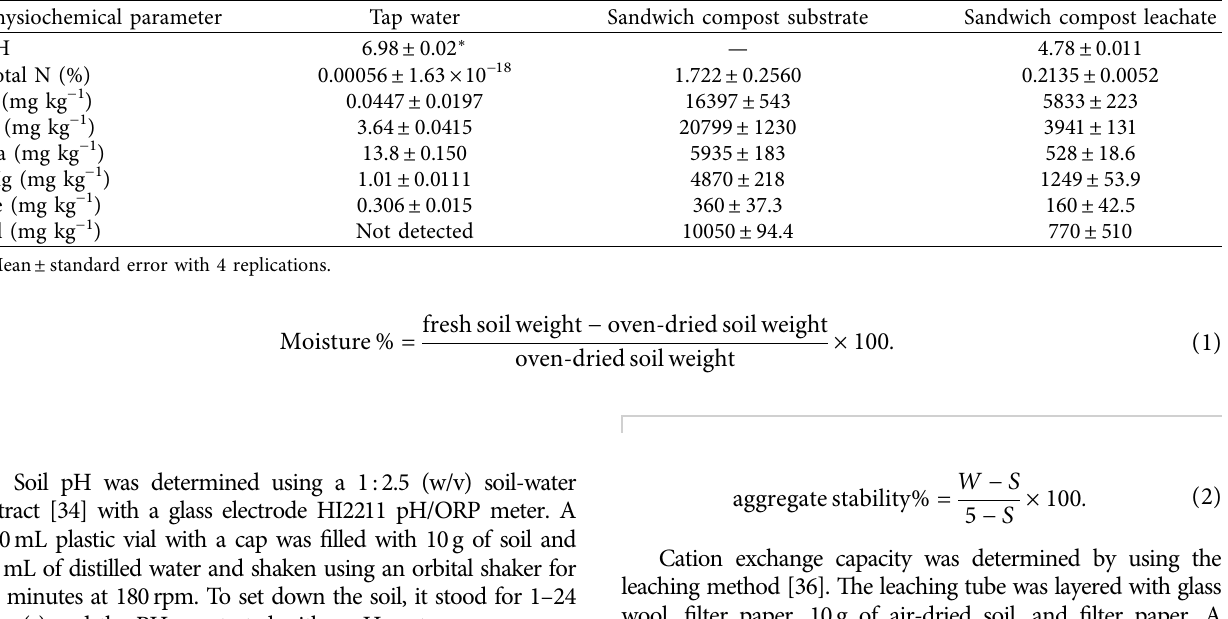
Table 3: Physiochemical parameters of tap water, Sandwich compost substrate, and leachate. Physiochemical